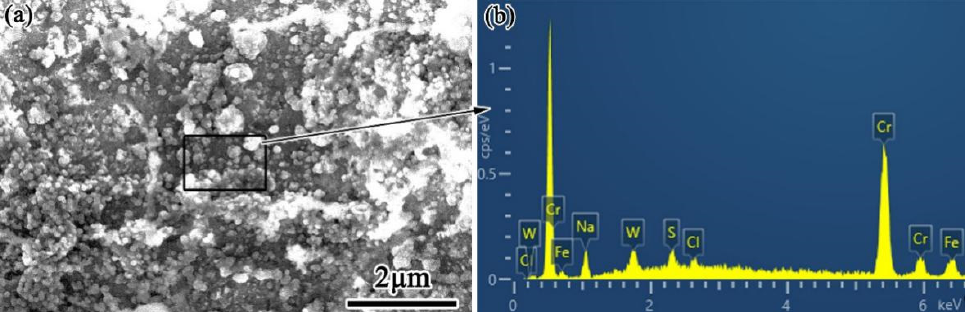
Figure 10. ( a ) Morphology and ( b ) elemental profile (analyzed by EDS) of the dissolved corrosion products precipitating from cleaning water.